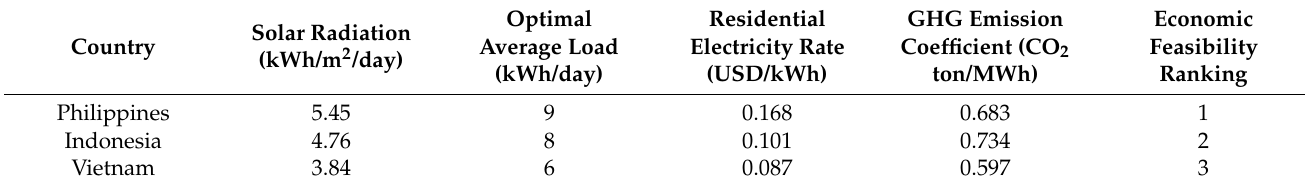
Table 20. Economic feasibility ranking of the proposed system in the three